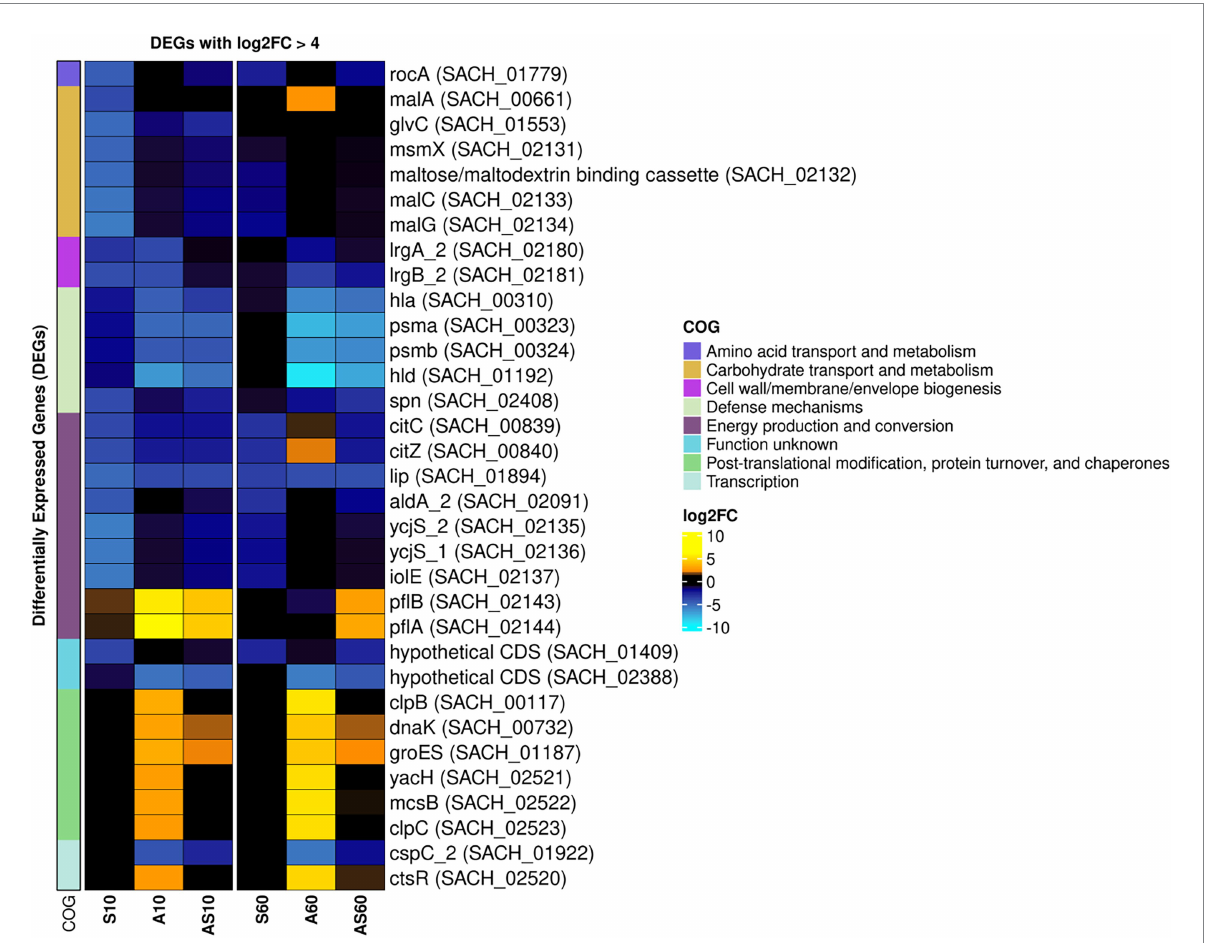
FIGURE 5 Heatmap of the top differentially expressed genes across all sample conditions. Top differentially expressed genes (DEGs) (n = 41) are visualized based on their respective log2 fold-change (log2FC) compared to the corresponding control samples. Each column corresponds to a stress condition (S = serum, A = ammonia, AS = ammonia & serum) and time point (10 min and 60 min). Genes are either strongly upregulated with log2FC > 5 (yellow) or downregulated with log2FC < − 4 (blue). Genes are furthermore annotated with corresponding COG ontologies (left